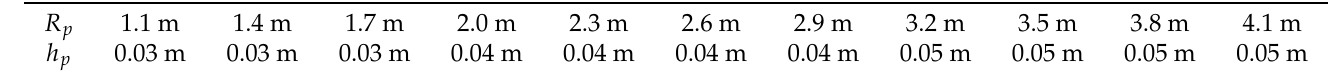
Table 2. Set of variable pile parameters.